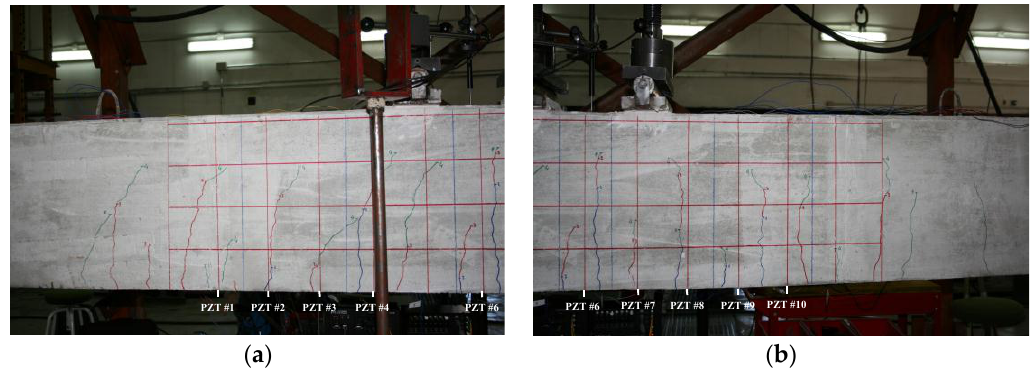
Figure 28. Cracking map of the beam after the last loading stage. ( a ) Left side of the beam; ( b ) right